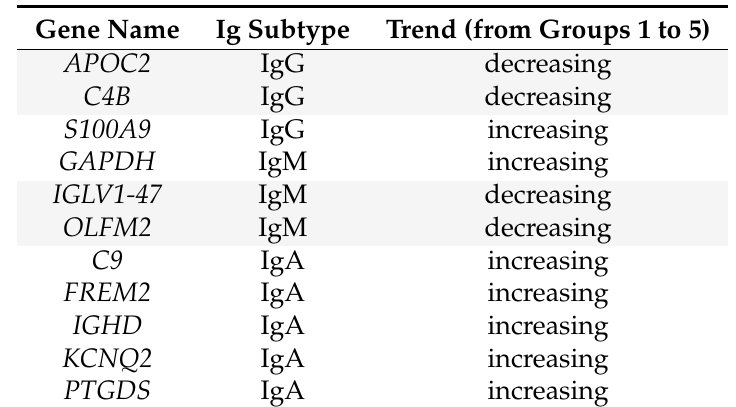
Table 3. List of significant Circulating Immune Complexes trends after